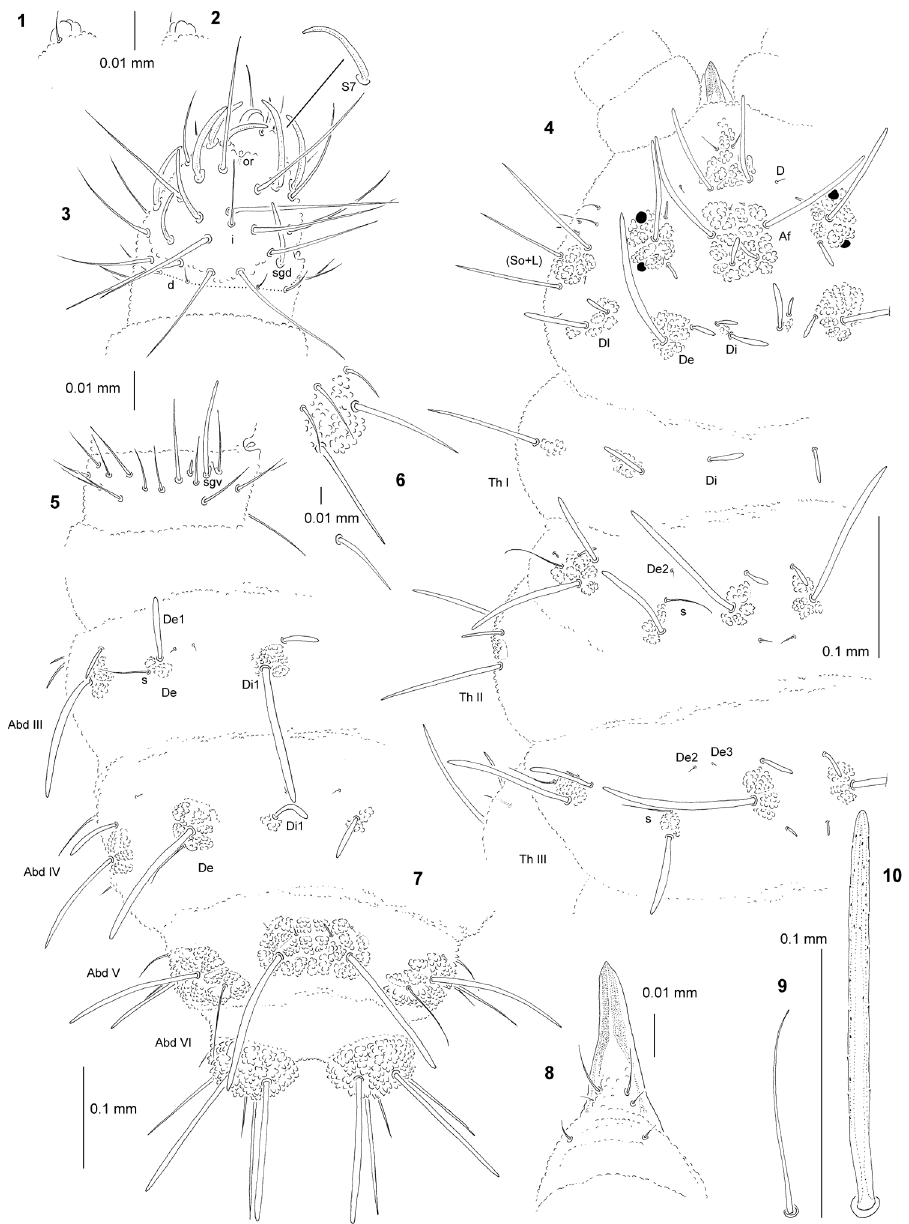
Figures 1–10. Endonura longirostris sp. n.: 1 apical bulb, dorsal view 2 apical bulb, ventral view 3 dorsal chaetotaxy of Ant III–IV 4 chaetotaxy of head and Th (holotype), dorsolateral view 5 ventral chaetotaxy of Ant III 6 tubercle L of Abd IV 7 dorsal chaetotaxy of Abd III–VI 8 chaetotaxy and ventral sclerifica- tions of labrum 9 sensillum of Abd V 10 chaeta Di1 of Abd